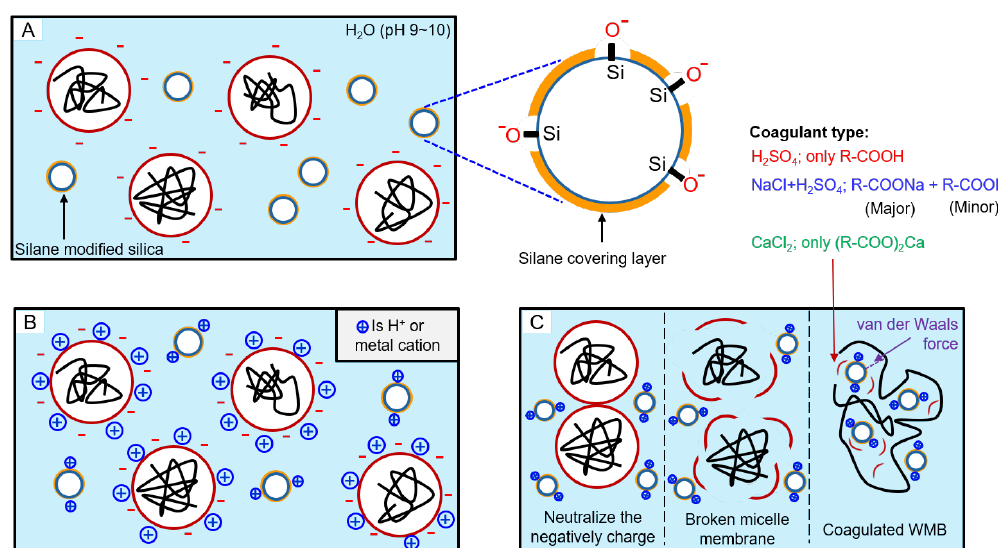
Figure 2. Illustration of the reaction among surface-modified silica, surfactant, and coagulant during WMB manufacturing process: ( A ) a state in which micelles and modified silica having a negative charge surface are dispersed in water, ( B ) a state after coagulants were added, and ( C ) a state in which modified silica and ESBR were coagulated. Also, by-products between emulsifier and cation remained, for example, carboxy acid, sodium carboxylate, and calcium carboxylate, according to the coagulant type. Table 5. pH value of WMBs according to the coagulant type.